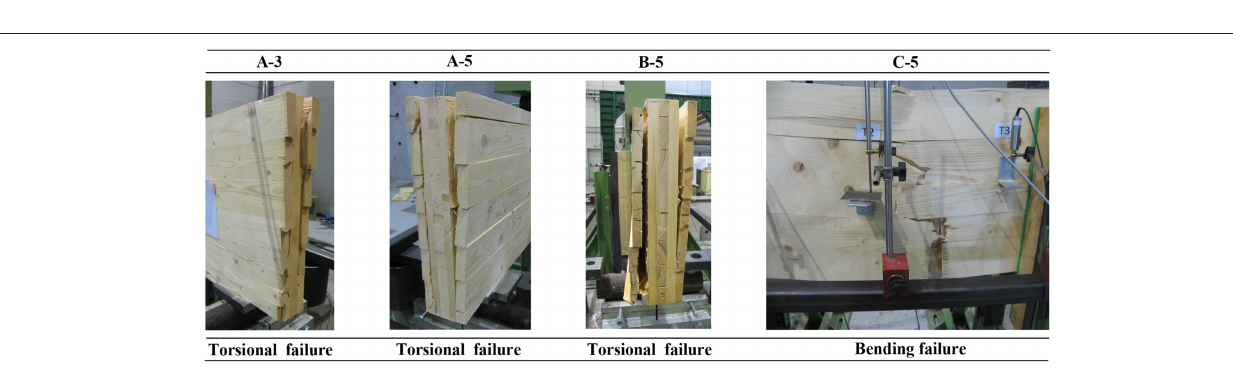
FIGURE 8 | Failure